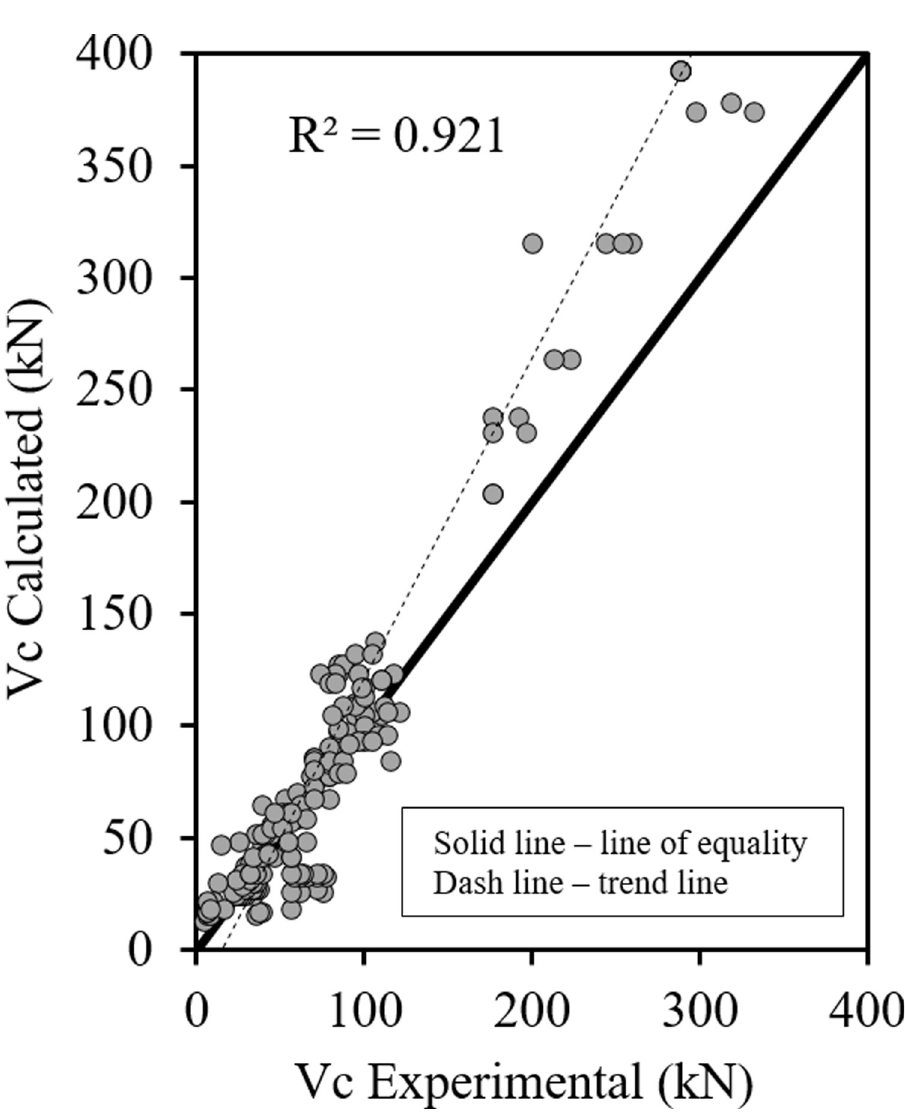
Fig 6. Shear strength of HSC beams (Eq